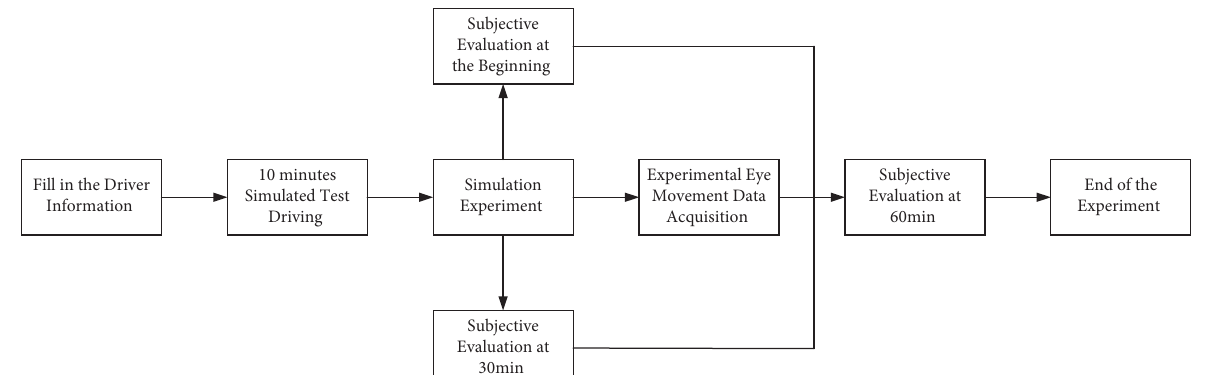
Figure 4: Simulation driving experiment